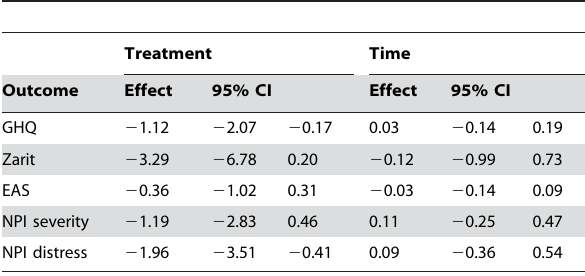
Table 3. Coefficient (95% confidence intervals) from the mixed effects